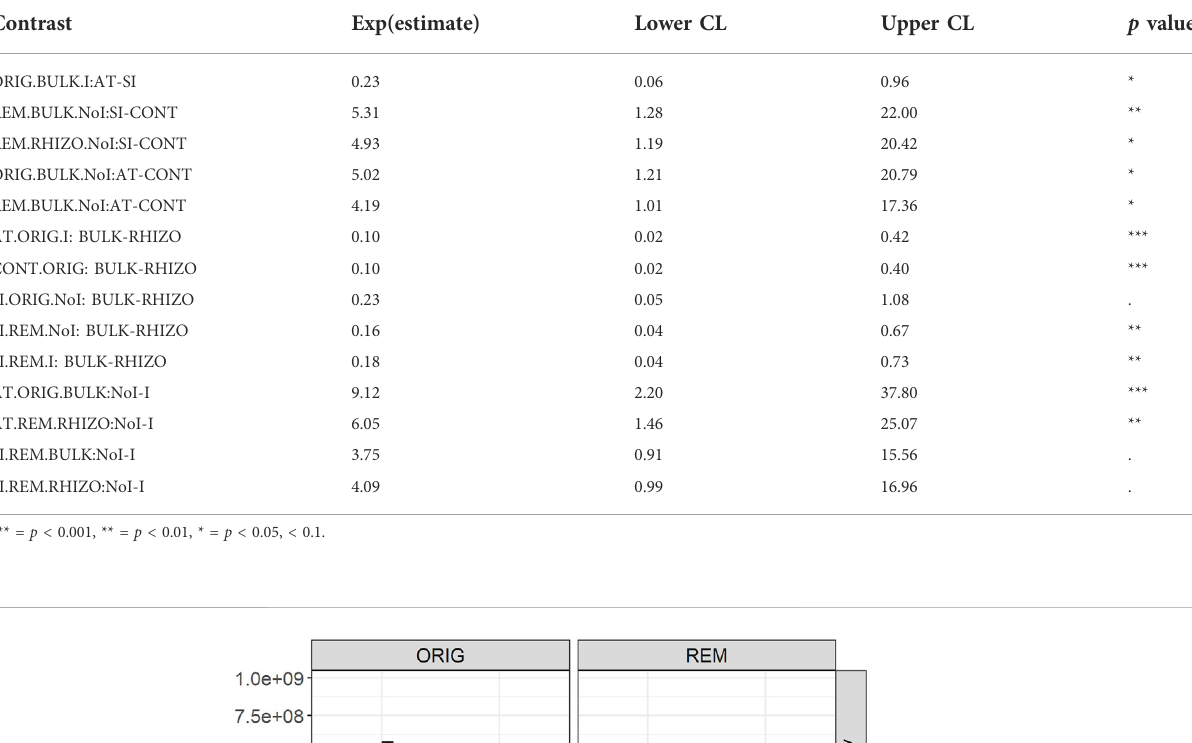
TABLE1EstimatedratiosofmeansoffungalITSabundance[location(AT,SI,CONT),remediation(ORIG,REM),plant(RHIZO,BULK),inoculum(I,NoI)] in contrast analysis with 95% con fi dence intervals. Only statistically signi fi cant contrasts are shown. Contrast Exp(estimate) Lower CL Upper CL p value